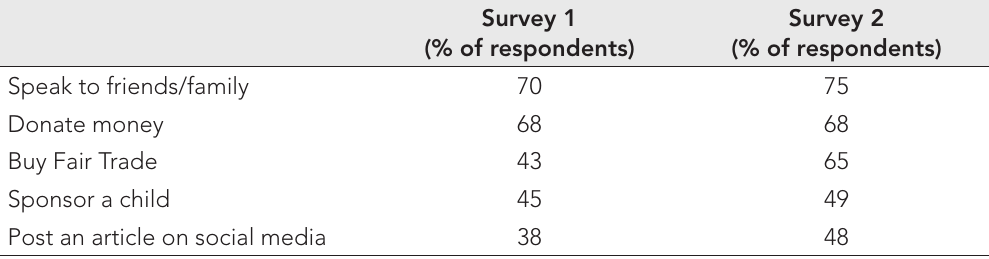
Table 5: Action in response to knowledge about global development aid